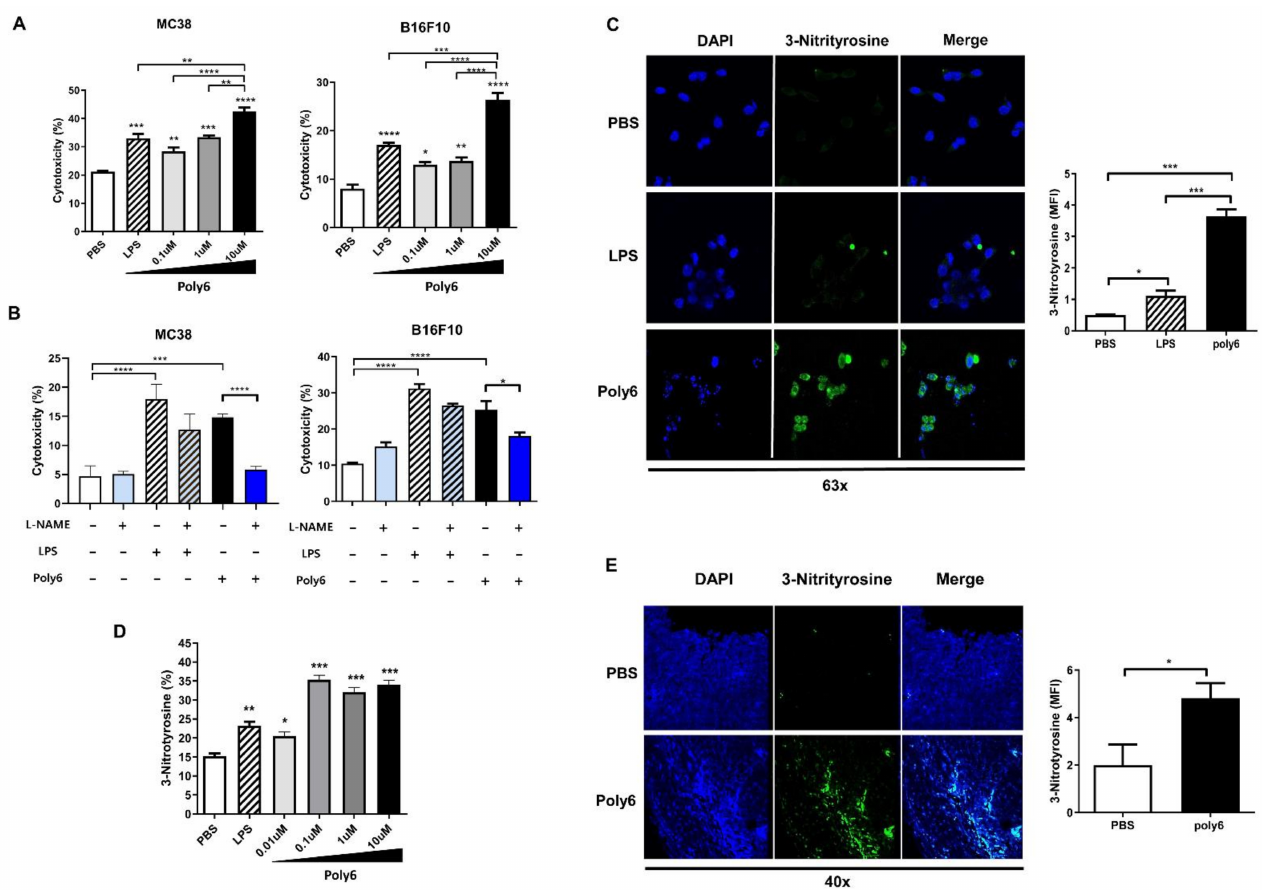
Figure 5. Poly6 leads to direct oncolytic activity of Tip-DCs in an NO-dependent manner. ( A ) Cancer cells (MC38 colon cancer, B16F10 melanoma cancer) were analyzed using a co-culture system with Tip-DCs generated by Poly6. DC2.4 cells were treated with Poly6 for 48 h, and CFSE-labeled cancer cells were co-cultured with Poly6 stimulated DC2.4 cells for 4 h. Then, dead cancer cells were evaluated by 7AAD positive staining and analyzed by FACS; n = 3 biologically independent samples. ( B ) Inhibited cytotoxicity of cancer cells by addition of L-NAME was evaluated by FACS. DC2.4 cells were treated with Poly6 (10 µ M) and/or L-NAME (5 mM) for 48 h. Poly6 stimulated DC2.4 cells and CFSE labeled cancer cells were co-cultured. 7AAD-positive and CFSE-labeled cancer cells were evaluated as an oncolytic response; n = 3 biologically independent samples. ( C ) Peroxynitrite levels were evaluated by assessing 3-nitrotyrosine levels. Supernatants of DC2.4 cells treated with Poly6 (1 µ M) for 48 h were treated with MC38 cancer cells for 4 h. Then, cancer cells were permeabilized and stained with 3-nitrotyrosine antibody. Images were analyzed by confocal microscopy; n = 3 biologically independent samples. ( D ) 3-Nitrotyrosine levels were analyzed by FACS; n = 4 biologically independent samples. ( E ) Peroxynitrite in tumor paraffin sections was evaluated by 3-nitrotyrosine staining and analyzed by confocal microscopy ( n = 4). These results are representative of two independent experiments. Significance differences (* p < 0.05, ** p < 0.01, *** p < 0.001 and **** p < 0.0001) among different groups are shown in related figures, and the data are presented as the mean ± standard error of mean (SEM). Student’s t -test, one- and two-way ANOVA were